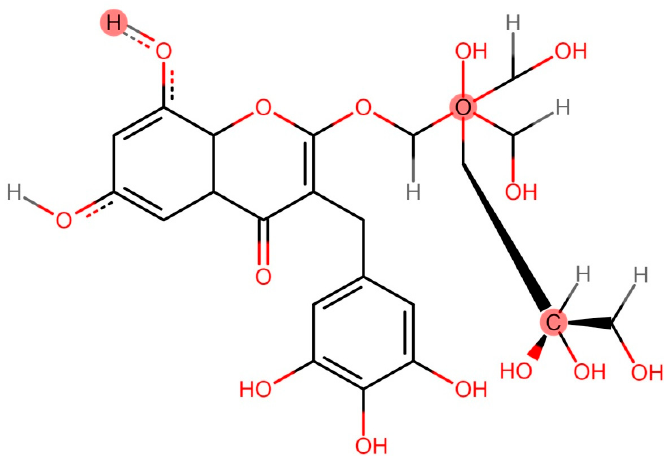
Figure 1. Structural formula of myricetin 3-O-d-galacto-pyranoside (M3G), C 21 H 20 O 13 , which acts as an anti-aging chemical by reducing the activity of aging-related proteins; ERK, JNK, and MAPK [54].